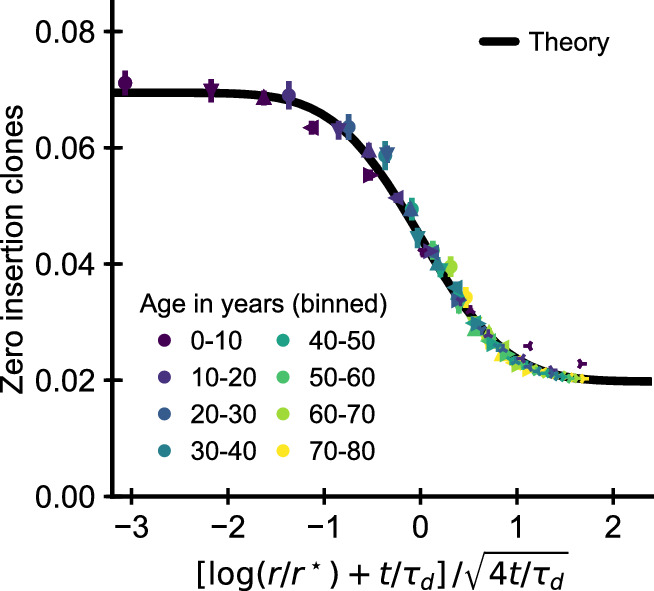
Data collapse by parameter rescaling for the simulated cohort.Same data as in Figure 3F displayed with a rescaled x-axis using fitted parameters τd=10.2±0.4⁢years,r⋆=1.19±0.08⋅104. The data collapses onto a sigmoidal function predicted by theory (Equation 3) with fitted p0,-=0.0695±0.0012, p0,+=0.0198±0.0003 (black line).